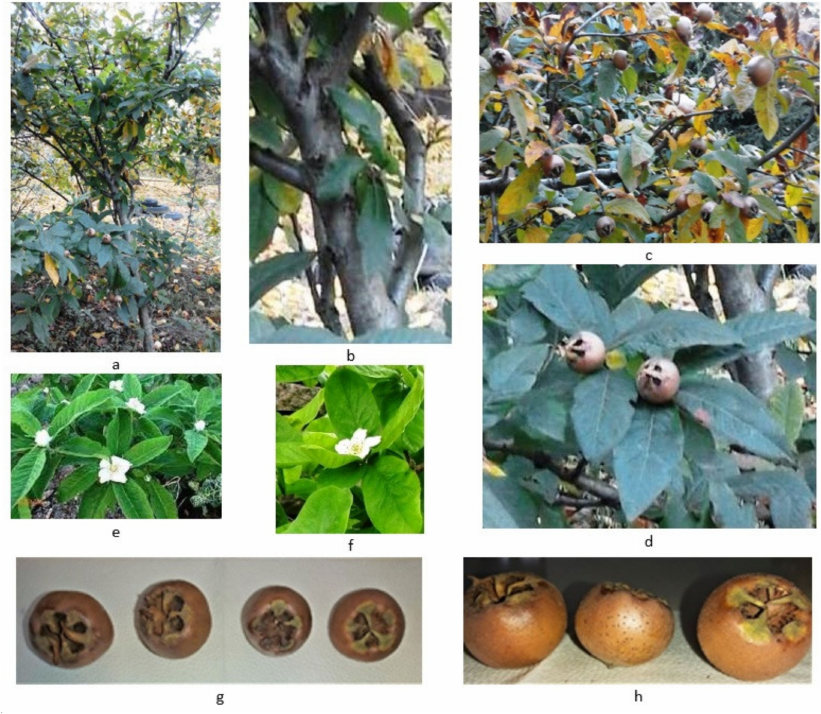
Figure 1. Medlar ( a )—tree (original); ( b )–bark (original); ( c , d,g,h )—fruits (original); ( d ) leaves (original); ( e , f )—flowers